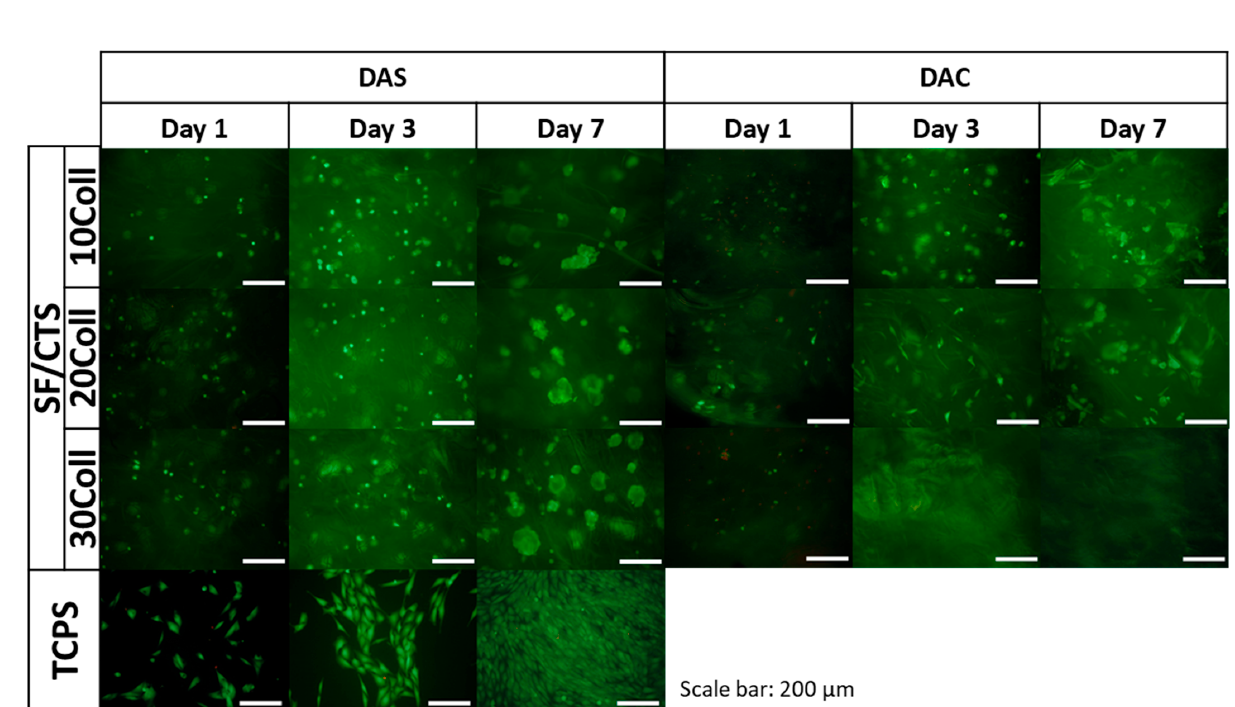
Figure 14. Images of MG-63 cells grown for one, three or seven days on SF/Coll 50/50 mixtures with 10, 20 and 30% addition of CTS, cross-linked with dialdehyde starch (DAS) and dialdehyde chitosan (DAC) scaffolds and on control TCPS. Live/dead staining. Scale bar = 200 μ m.